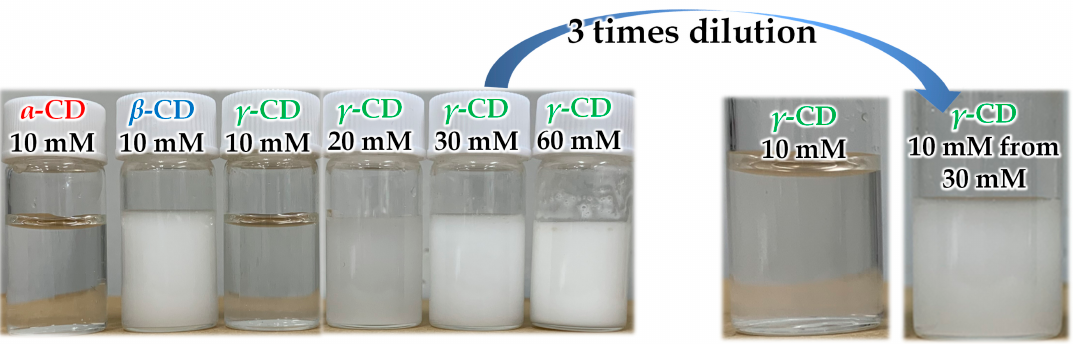
Figure 2. Photographs for I and for a sample diluted from 30 mM to 10 mM of γ -CD, respectively.